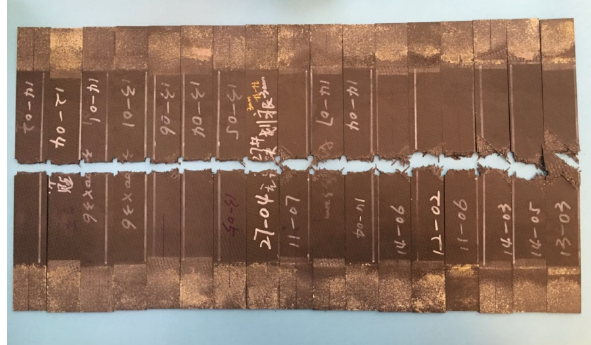
Figure 6: View of 3mm depth notched specimens after tension- tension fatigue test ( R